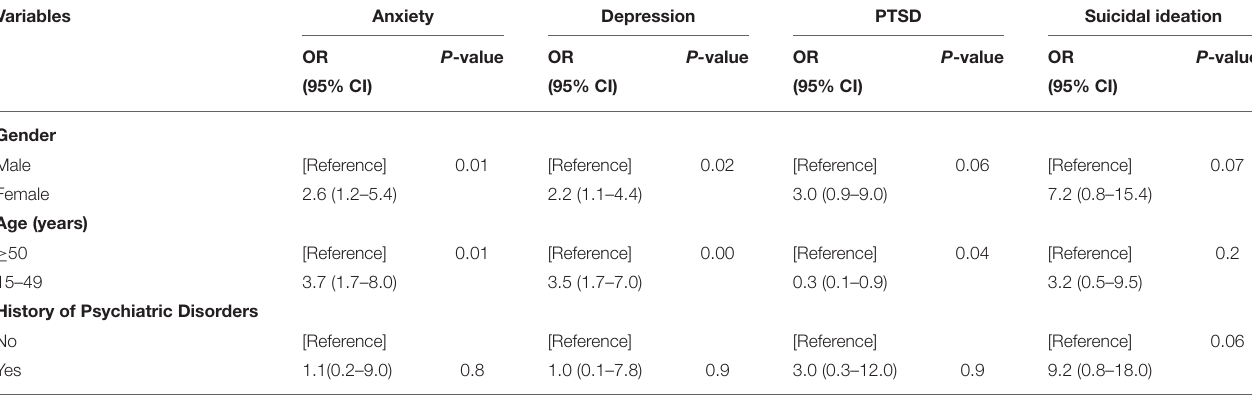
TABLE 3 | Regression analysis of risk factors for symptoms of anxiety, depression, PTSD, and suicidal ideation.